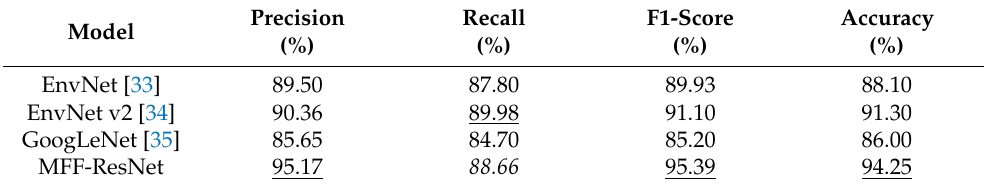
Table 3. Comparison of algorithms based on ESC10 datasets (the best performance is underlined).